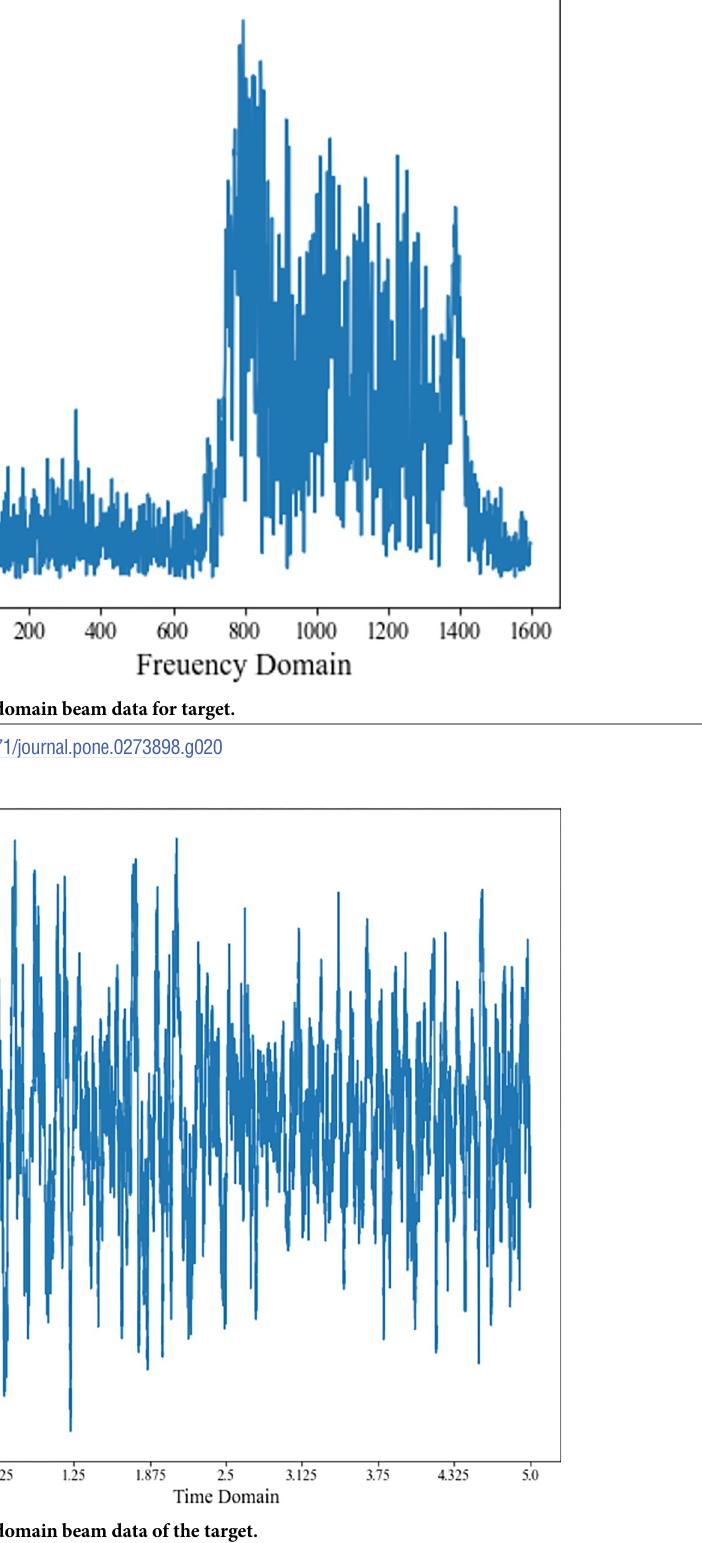
Fig 21. Frequency domain beam data of the target.